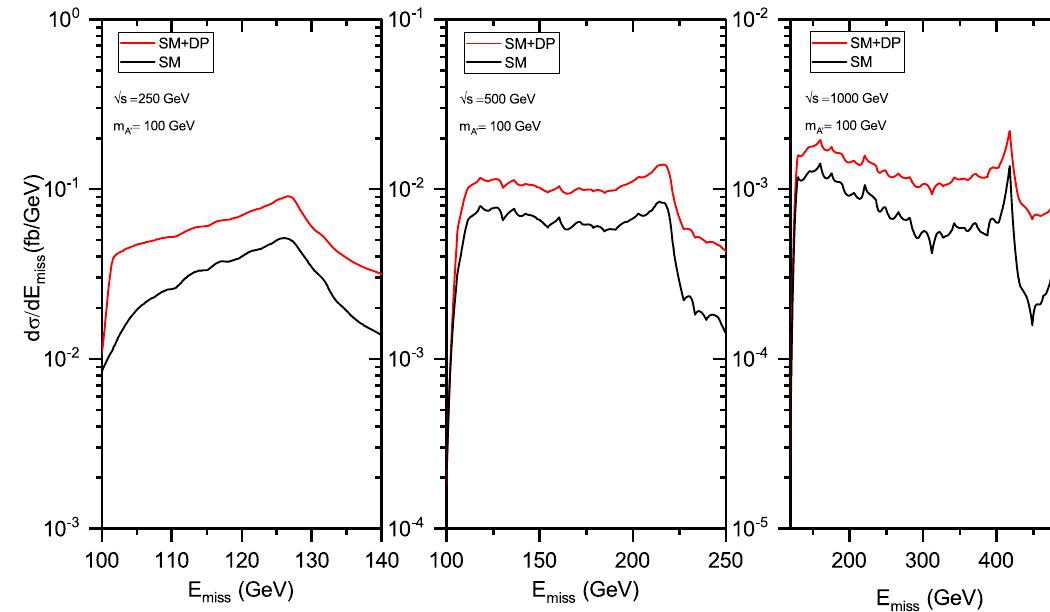
Fig. 7 The same as in Fig. 6, but for the collider ILC